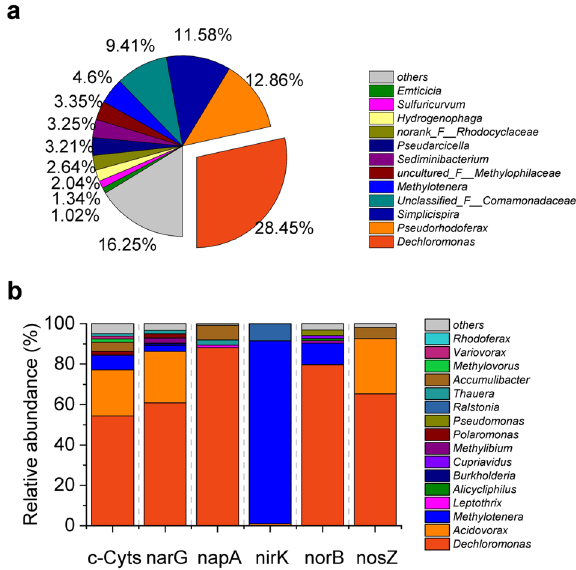
Fig. 4 Functional bacterial community and genes in the micro- structure on iron rod in Fe-sediment system. a Bacterial commu- nity composition in the microstructure. b Distribution of denitri fi cation genes in the iron rod surface microstructure. The category “ others ” represents the genera and genes with relative abundances below